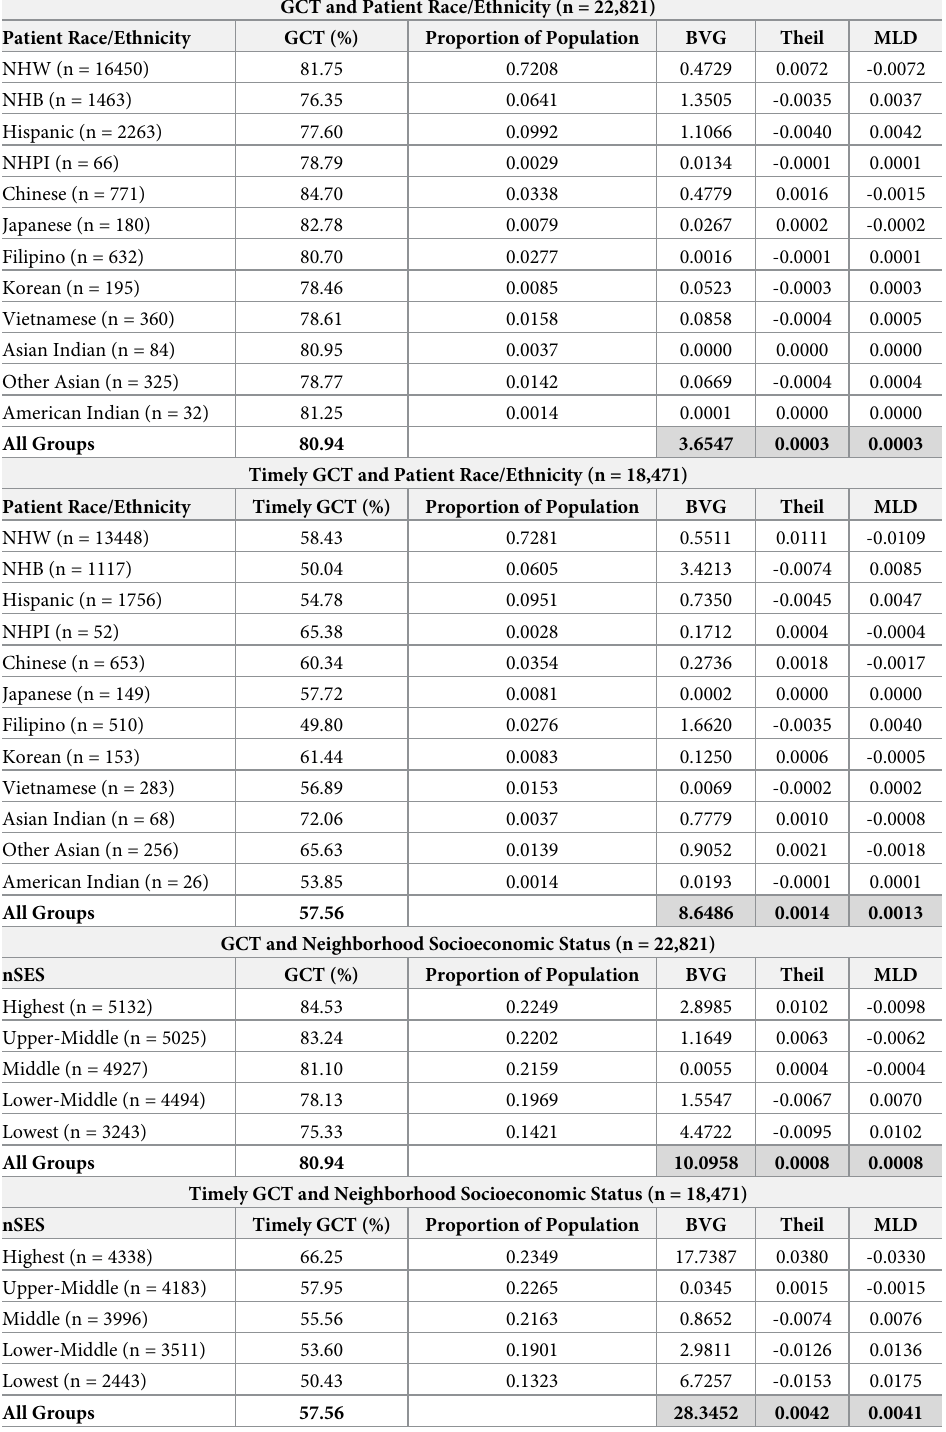
Table 2. Absolute and relative disparities in rate of GCT and Timely GCT between patient race/ethnicity groups and neighborhood socioeconomic status (nSES). GCT and Patient Race/Ethnicity (n =